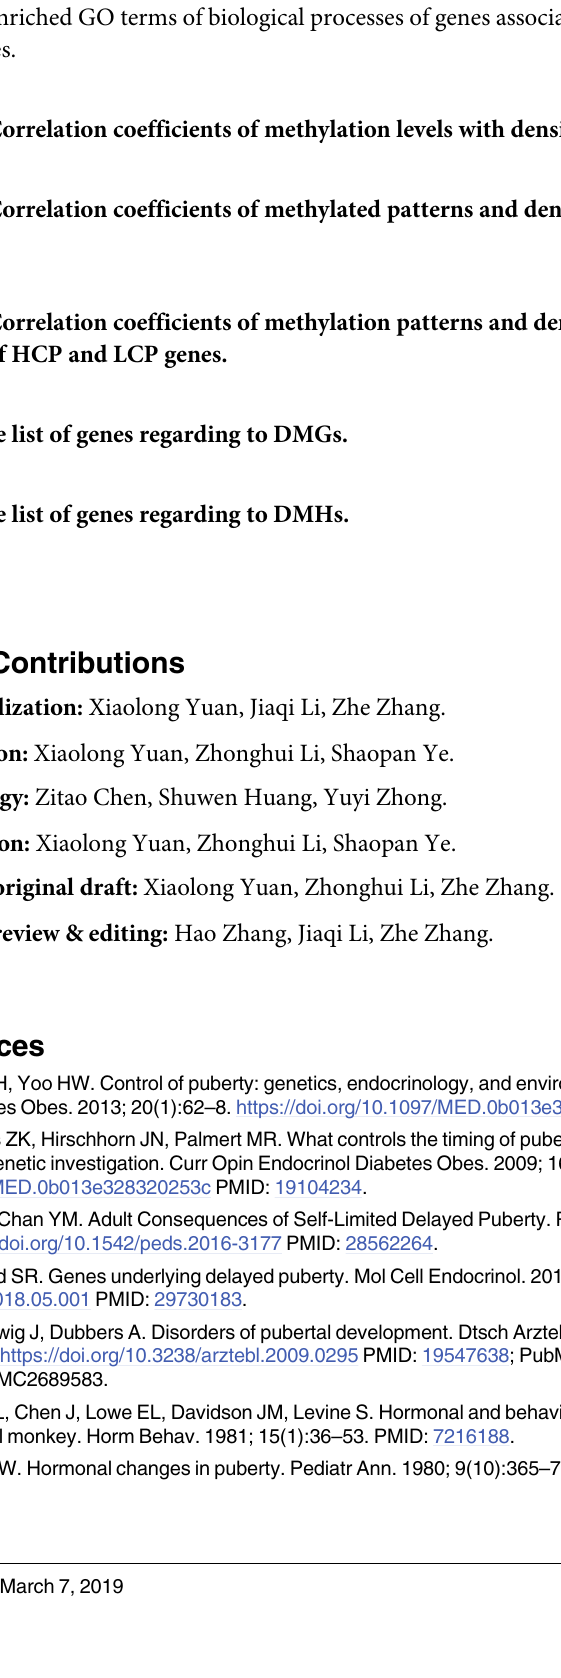
S1 Fig. GO term analysis of DNA methylation changes. ( a ) The significantly enriched GO terms of biological processes of genes associating with CpG methylation changes. ( b ) The sig- nificantly enriched GO terms of biological processes of genes associating with CpH methyla- tion changes. S1 Table. Correlation coefficients of methylation levels with densities of genes and CGIs. S2 Table. Correlation coefficients of methylated patterns and densities of CpHs at genic locations. S3 Table. Correlation coefficients of methylation patterns and densities of CpHs at the locations of HCP and LCP